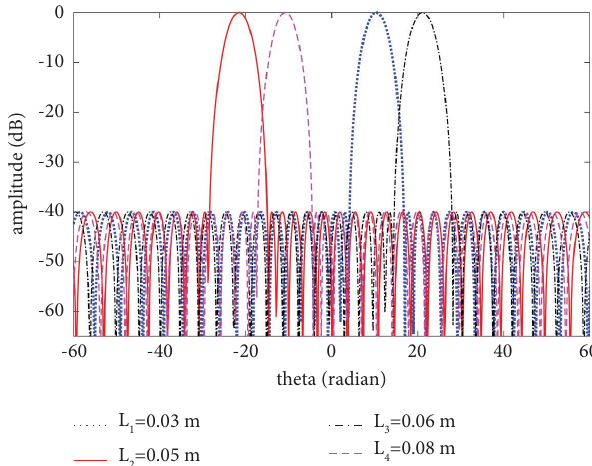
Figure 11: 4-beamforming